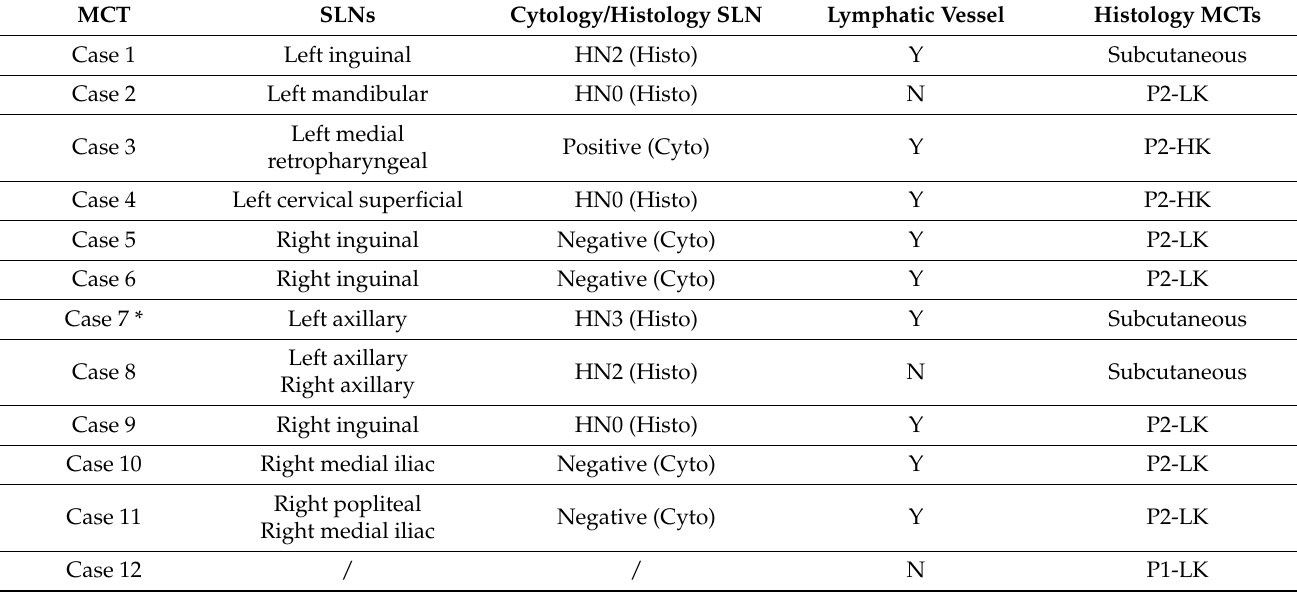
Table 3. Histological diagnosis of MCTs, cytology/histology of SLNs compared with the location of SLNs, presence or absence of lymphatic